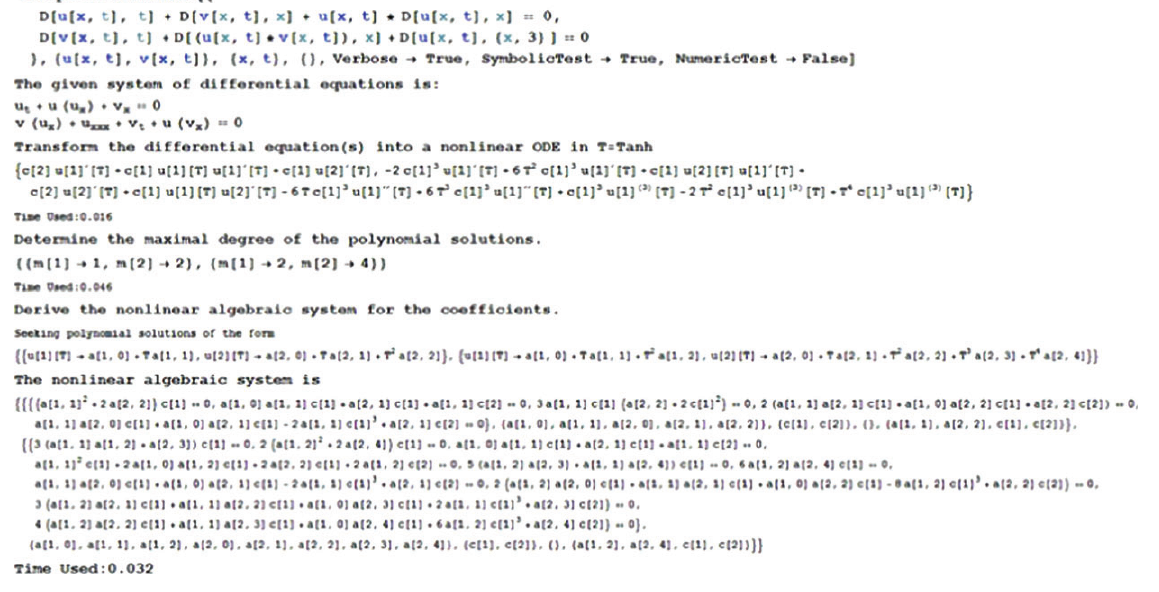
Figure 15 Boussinesq wave system by using Mathematica ® : first steps of the